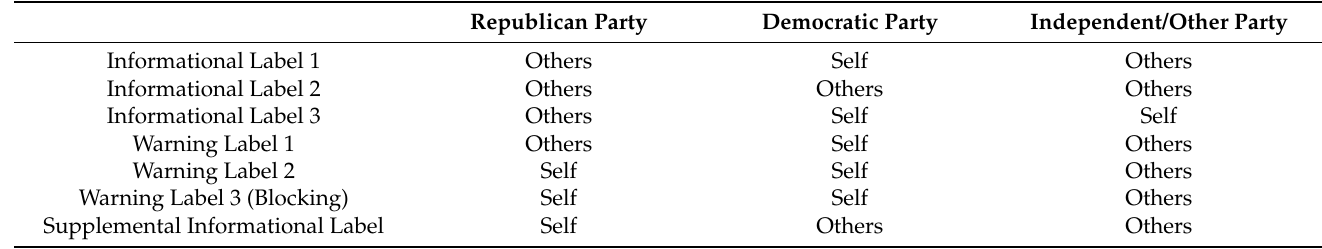
Table 8. Whether respondents saw labels as more valuable to self or others by party